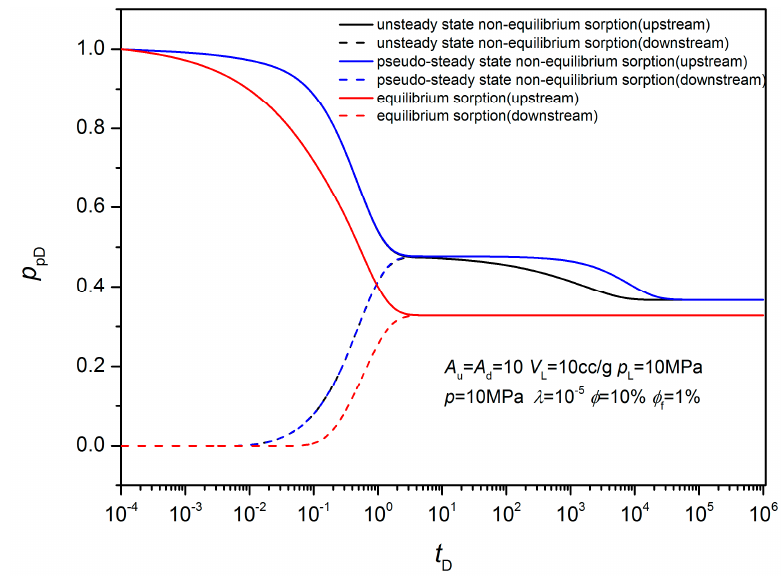
Figure 5. The comparison of the curves of the equilibrium sorption and the non-equilibrium sorption models.